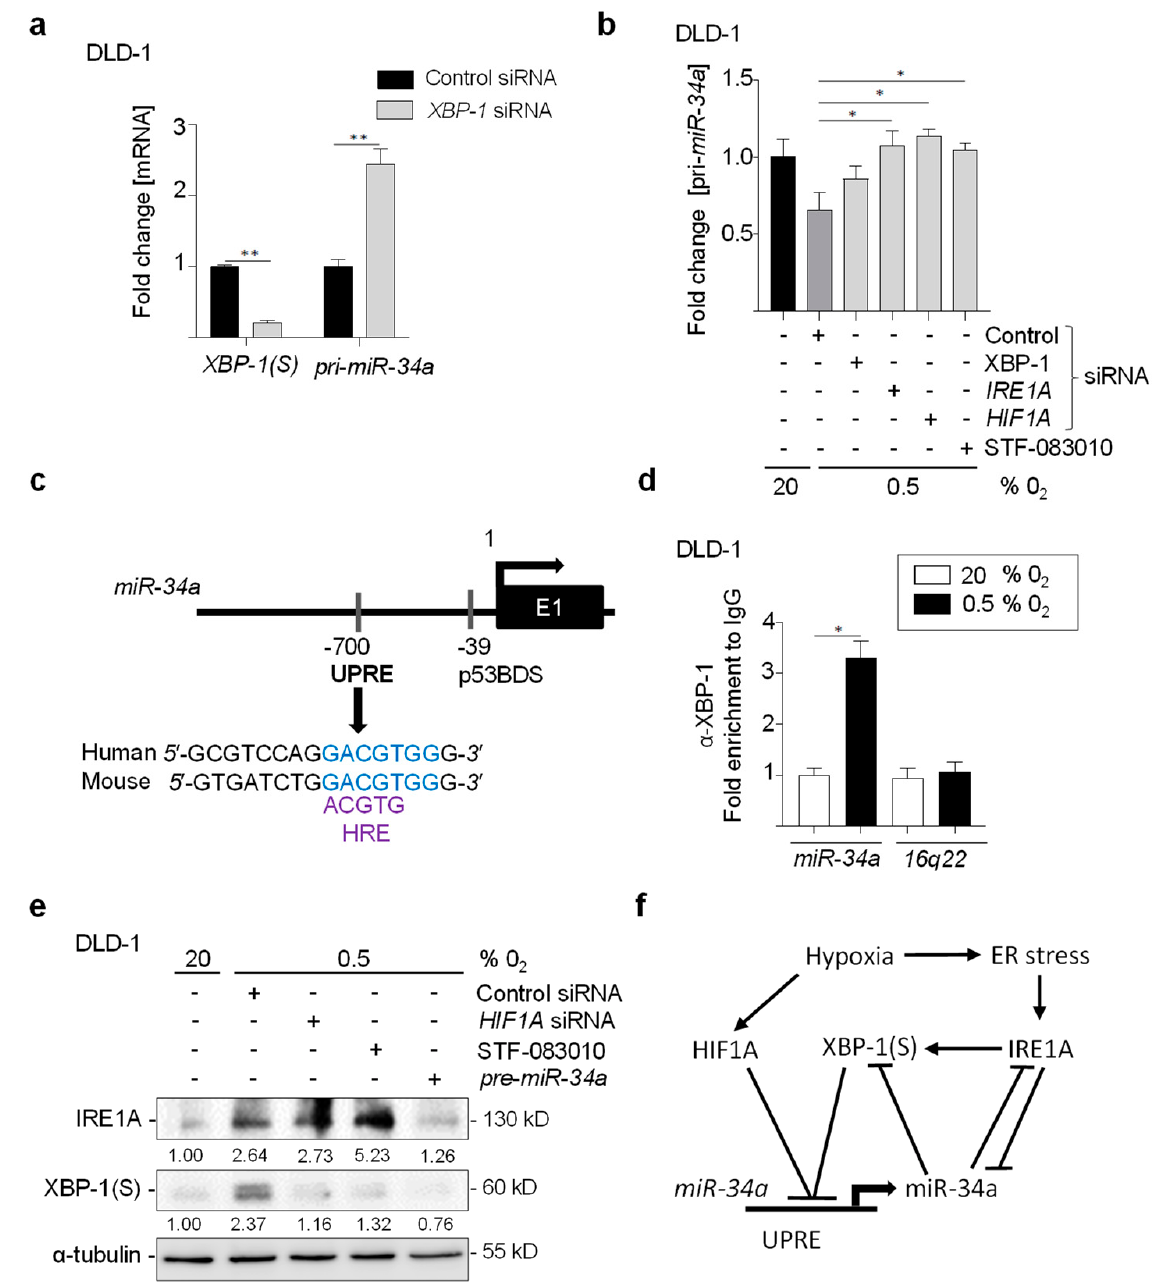
Figure 5. MiR-34a and XBP-1IRE1A/HIF1A form a double-negative feedback. ( a ) qPCR analysis in DLD-1 cells transfected with XBP-1 or control siRNAs for 24 h, then cultured at 20% O 2 or 0.5% O 2 for 72 h. ( b ) qPCR analysis of pri-miR-34a in DLD-1 cells transfected with XBP-1, IRE1A, or control siRNAs, or treated with STF-083010, for 24 h then cultured at 20% or 0.5% O 2 for 72 h. ( c ) Map of the human miR-34a genomic region indicating conserved XBP-1(S) binding sites. ( d ) Chromatin immunoprecipitation analysis of XBP-1(S) occupancy at human miR-34a and 16q22 locus served as negative control. ( e ) Western Blot analysis in DLD-1 cells transfected with HIF1A or pre-miR-34a or control siRNAs, or treated with STF-083010 for 24 h, then cultured at 20% or 0.5% O 2 for 72 h. ( f ) Model of the coherent feed-forward regulations of and downstream effects. In panel ( a , b , d ), mean values ± SD (n = 3) are provided. (**) p < 0.01, (*) p < 0.05.